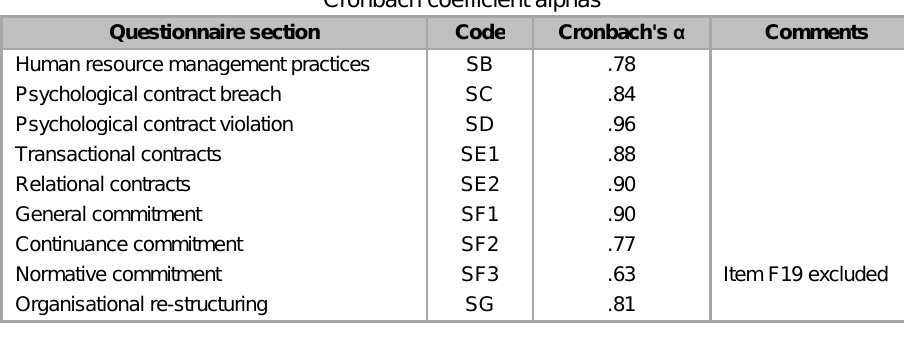
Frequency distribution of demographic variables of the sample